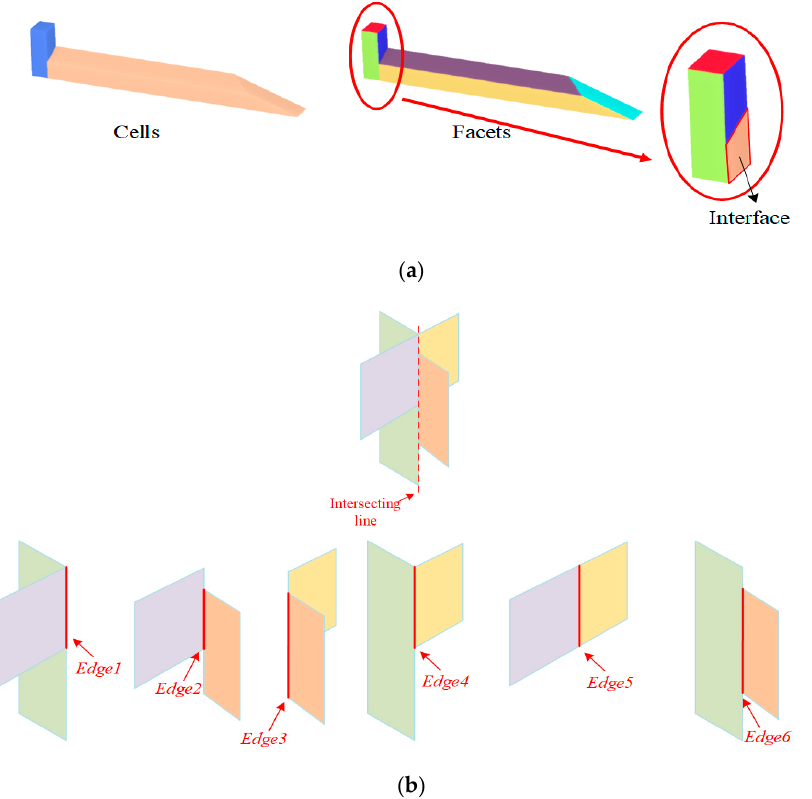
Figure 6. 2D and 1D topological relations between the 3D cells. ( a ) 2D topological relations between 3D cells are derived from the interfaces between cells and represented as 3D facets; ( b ) 1D topological relations between 3D cells are derived from the intersecting lines and represented as 3D